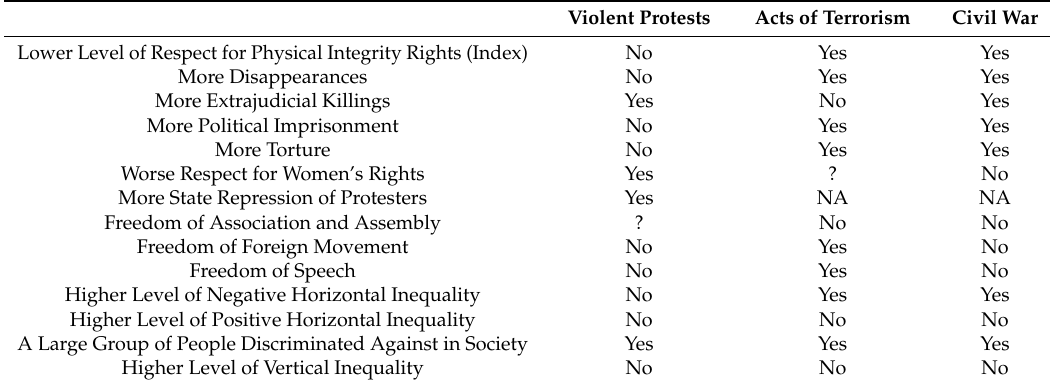
Table 5. Factors Associated with Either the Increased Risk of Onset or Greater Numbers of Violent Protests, Terrorism Events, or Civil War Deaths. Violent Protests Acts of Terrorism Civil War Lower Level of Respect for Physical Integrity Rights